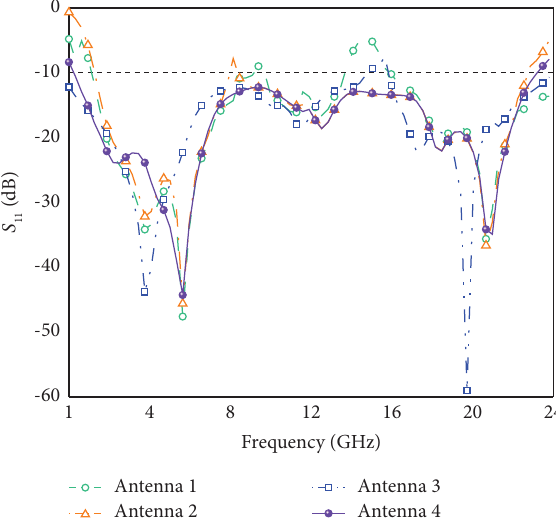
Figure 2: Diferent S 11 corresponding to diferent patch.